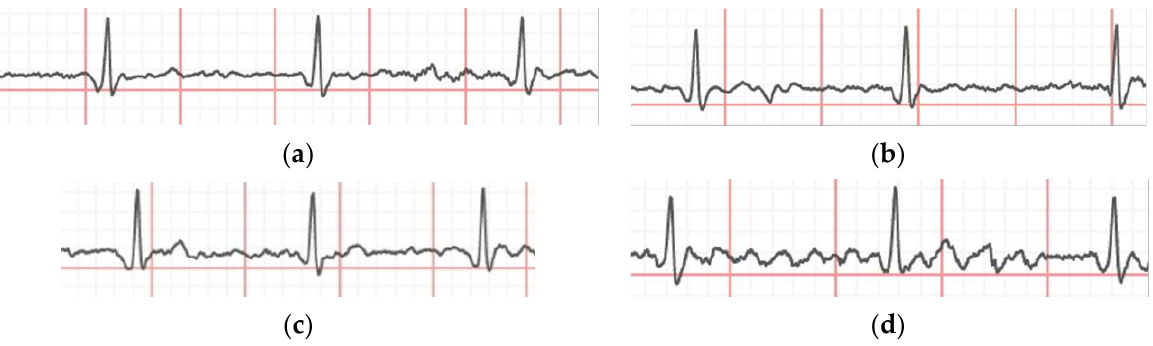
Figure 11. Figure ( a ) is an electrocardiogram obtained from an untreated “Tatami” needle electrode with 0.3 mm stitch density of stainless steel embroidery fabric. Figure ( b ) is an electrocardiogram of a “Tatami” needle electrode with 0.3 mm stitch density of stainless steel embroidery fabric treated with distilled water. Figure ( c ) is an electrocardiogram of a “Tatami” needle electrode with 0.3 mm stitch density of stainless steel embroidery fabric treated with alkaline sweat. Figure ( d ) is an electrocardiogram of a “Tatami” needle electrode with 0.3 mm stitch density of stainless steel embroidery fabric treated with acid sweat.